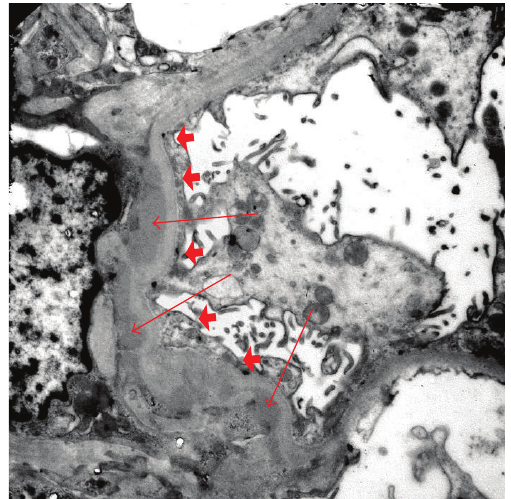
Figure 2: Electron microscopy of renal biopsy with paramesangial deposits (arrows) and foot process effacement (arrow